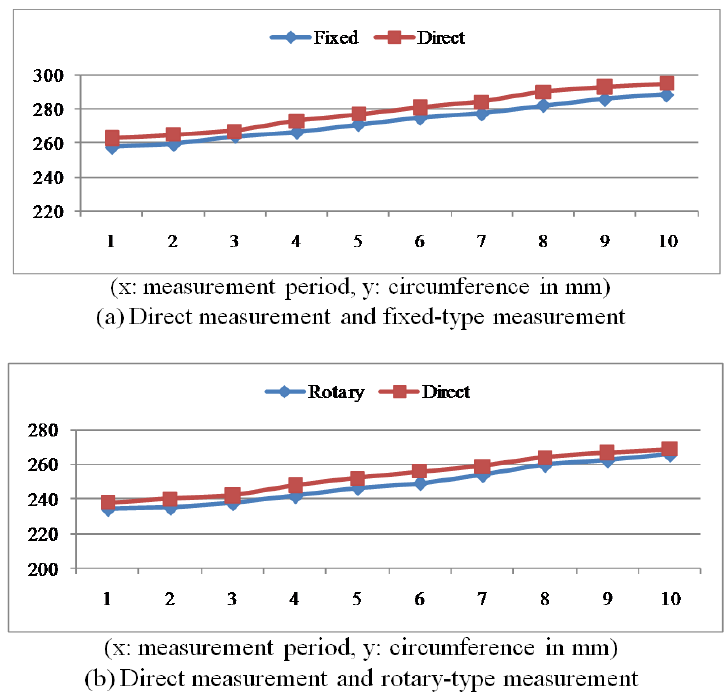
Figure 26. Comparisons of measurement